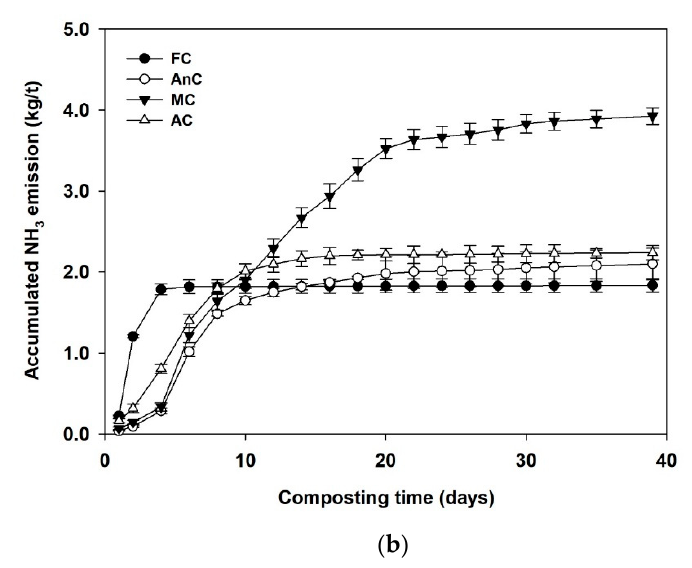
Figure 4. Accumulated gaseous emission of N 2 O ( a ) and NH 3 ( b ) during dairy manure composting. FC—farmer compost; AnC—anaerobic compost; MC—mixed compost; AC—aerobic compost.